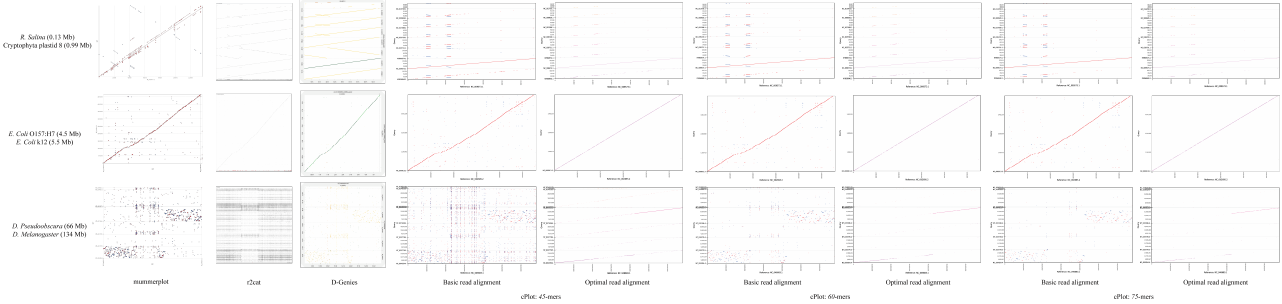
Figure 3. Comparative visualized results for mummerplot, r2cat, D-Genies, and cPlot. The mummerplot in Figure 3 has the problem of overlapping the alignment results of the Cryptophyta plastid genome, which is less than 1 Mb, while cPlot shows identifiable alignment results for the same dataset, and has no deviation in various k -mer values. cPlot and r2cat align relative regions accurately in a genome of less than 10 Mb. However, r2cat has the limitation that represents unidentifiable results in the large D. Pseudoobscura genome. However, cPlot clearly identifies the alignment region in the same case, and has high performance, especially if the k -mer value is large in proportion to the genome. Short-read alignment has limitations in identifying repeat regions due to read length constraints. This means that identifying more candidates of repeat regions provides better performance. We performed the comparative analysis of cPlot (Figure 4). Although D- Genies represents more accurate results (Figure 3) overall than mummerplot and r2cat in genomes of various sizes, it only identifies some repeat regions (Figure 4A). On the other hand, repeat regions show that cPlot (Figure 4B) finds and indicates more repeats at positions 20,000 bp and 40,000 bp. These results show that cPlot outperforms other algorithms, and it derives meaningful results for further analysis on the same dataset.